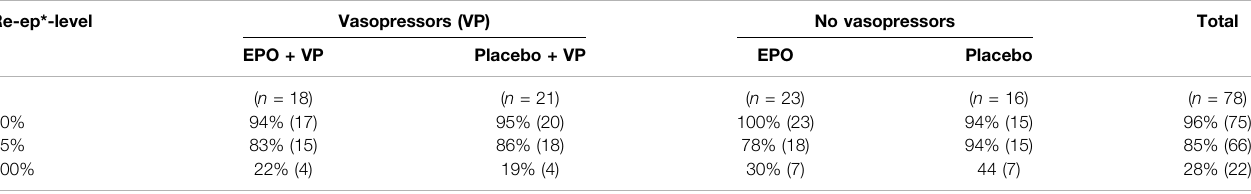
TABLE 11 | Likelihood of achieving the designated re-epithelialization levels within the observation period by subgroup stratum.